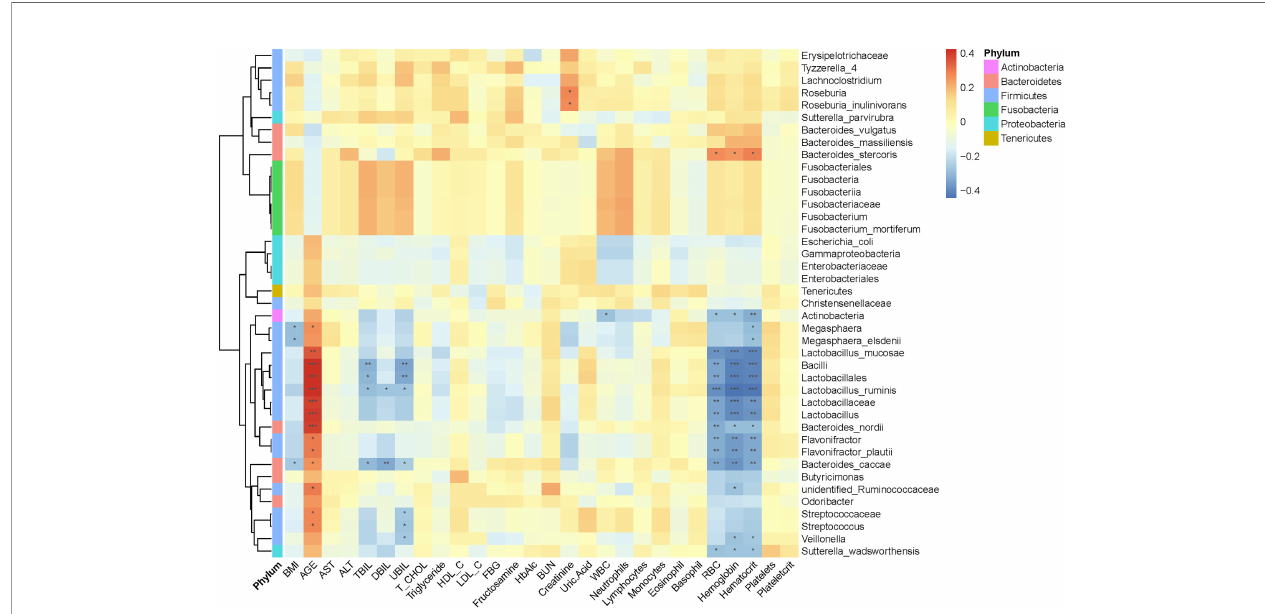
FIGURE 5 | Association between clinical information and microbiota composition at the previously depicted differential bacteria. Notes: * p < 0.05, ** p < 0.01, *** p < 0.001. BMI, body mass index; ALT, alanine aminotransferase; AST, aspartate aminotransferase; TBIL, total bilirubin; DBIL, direct bilirubin; UBIL, unconjugated bilirubin; T_CHOL, total cholesterol; HDL_C, high-density lipoprotein cholesterol; LDL_C, low-density lipoprotein cholesterol; FBG, fasting blood glucose; HbA1c, glycosylated hemoglobin; BUN, blood urea nitrogen; WBC, white blood cells; RBC, red blood